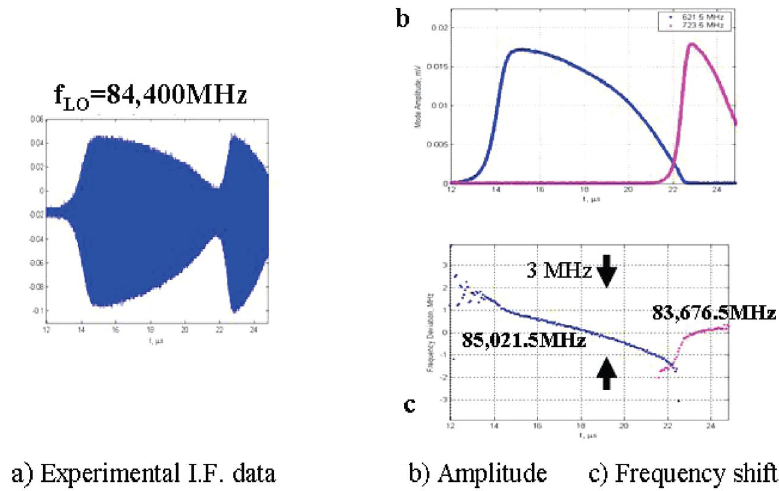
FIG. 3. (Color) Mode hopping associated with the accelerating-voltage drop: (a) IF oscillogram, (b) growth and decay of the 2 modes, (c) isolated frequency chirp measurement of the two modes (here f (frequency decreases with time). The chirp is seen as positive for the 83 676 : 5 MHz mode because the mode frequency f that of the local oscillator f effect). See also Fig. 4.